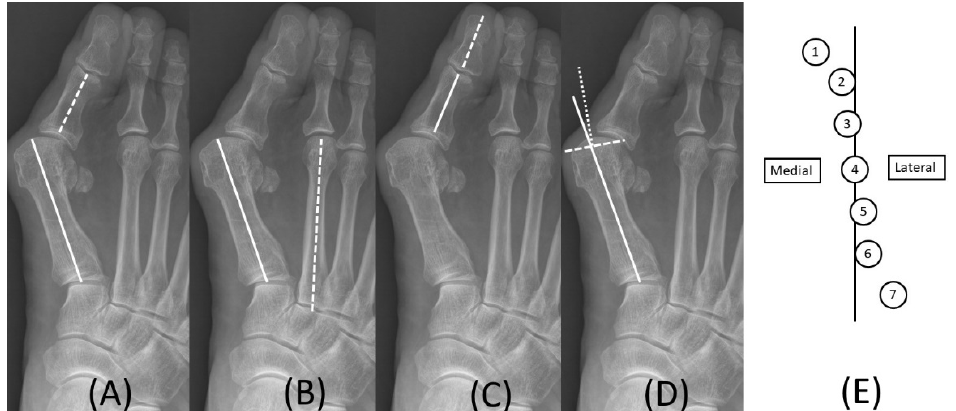
Figure 1. Preoperative angle measurements in a plain radiograph. Hallux valgus angle was defined as the intersection angle made by the longitudinal axis of the first metatarsal (solid) and proximal phalanx (dash) ( A ); The intermetatarsal angle was the intersection angle made by the longitudinal axis of the first (solid) and second (dash) metatarsal ( B ); Hallux valgus interphalangeal angle was